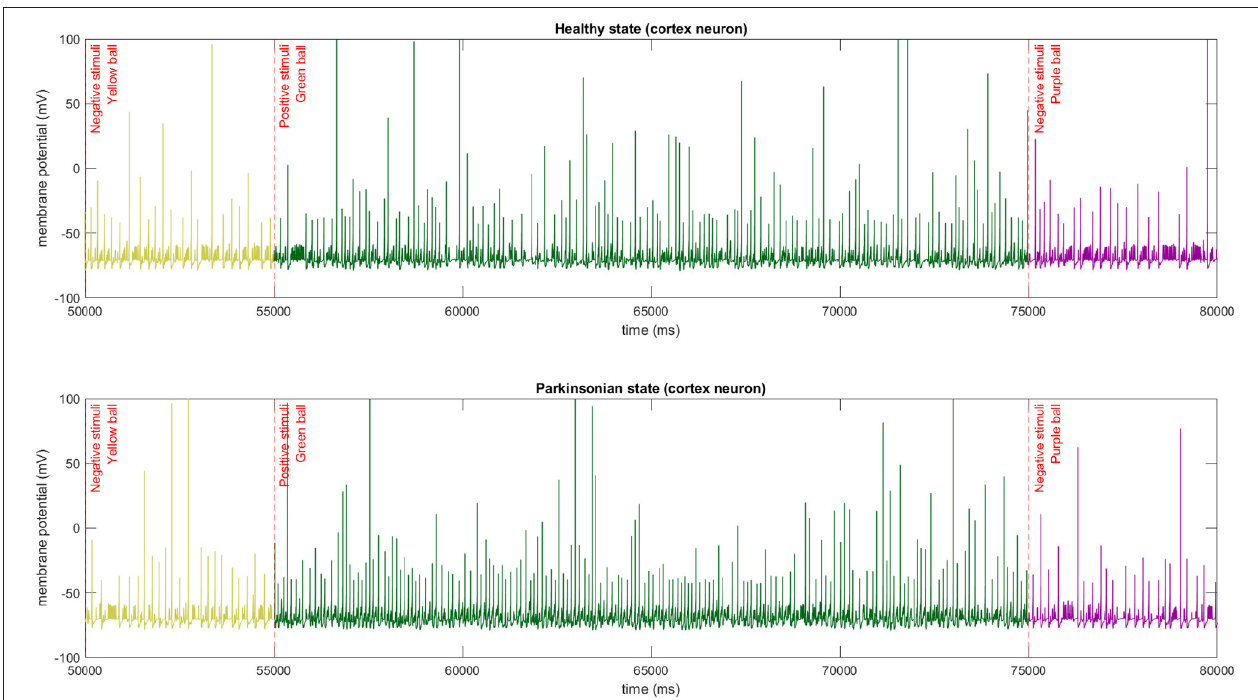
FIGURE 12 | The membrane potential of a single cortical neuron after different stimulus being applied to thalamic neurons. In this experiment, we used the same sequence of stimulus in both conditions of the model. The abrupt change of firing spikes can be easily observed in the graphics.